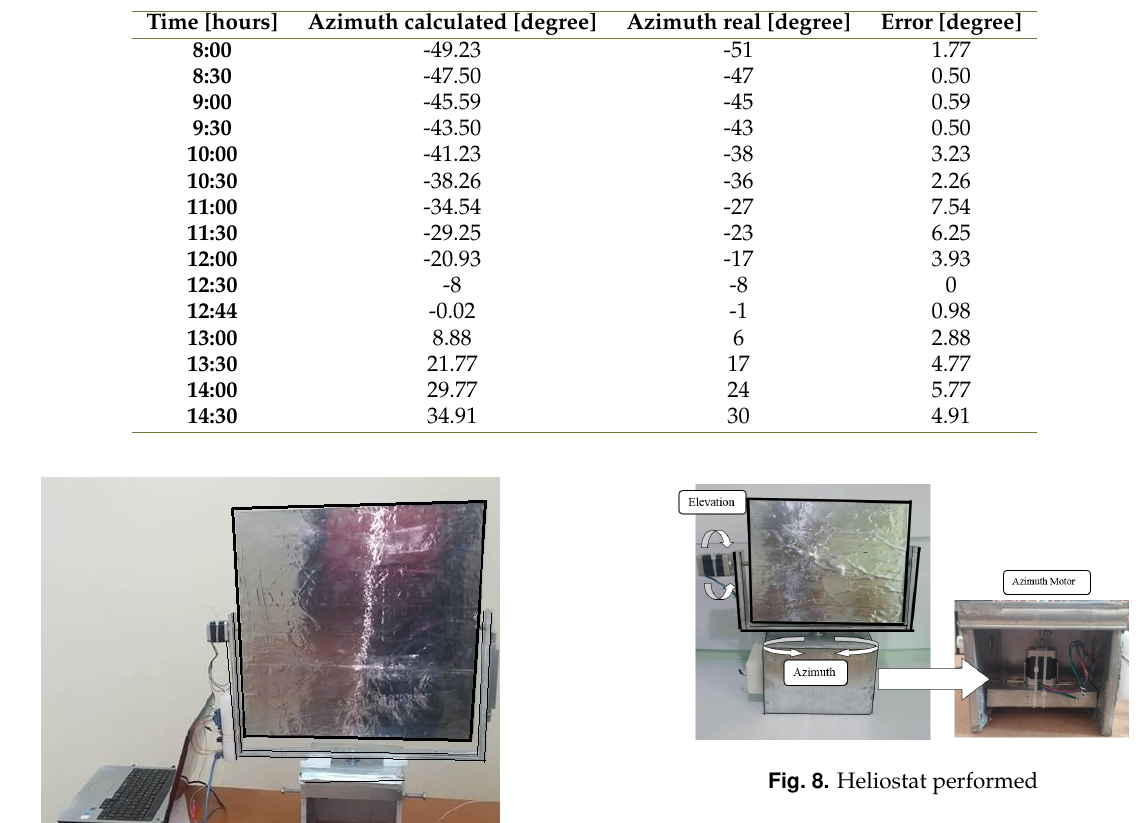
Table 6. Azimuth test result